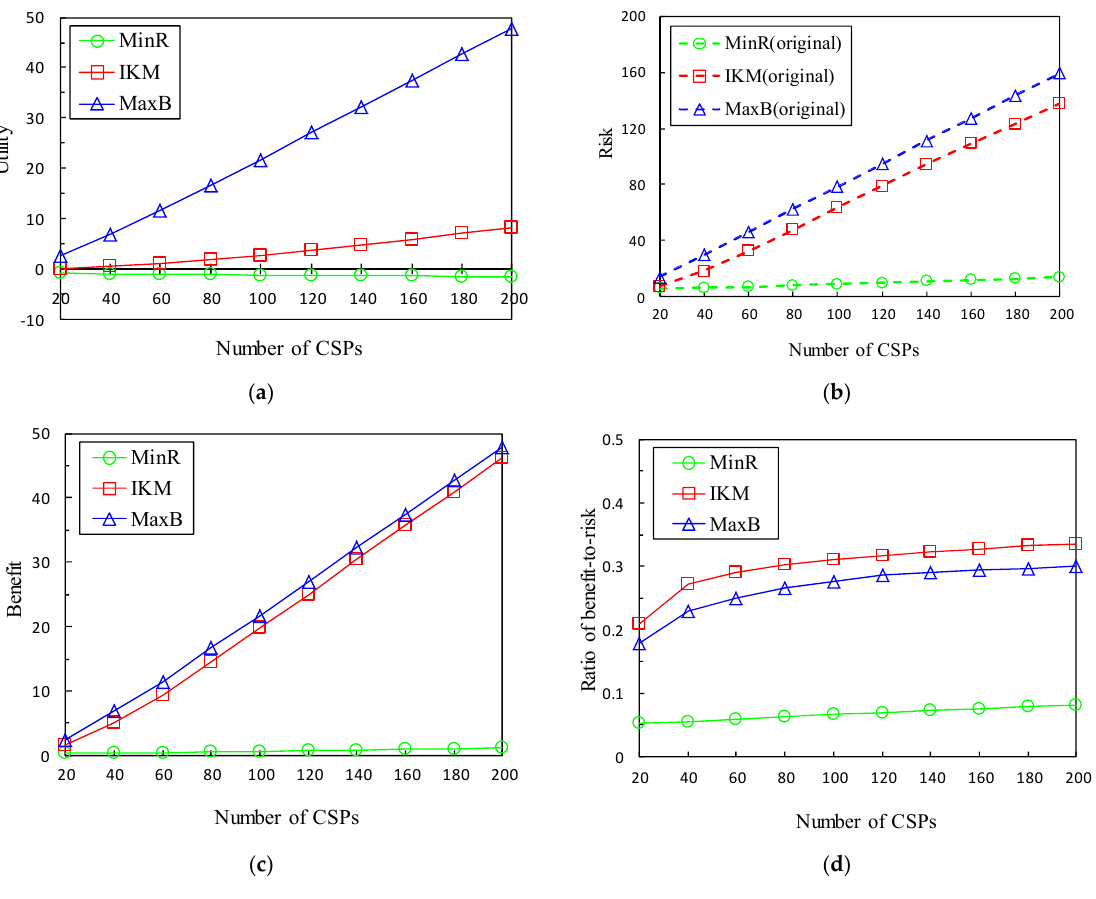
Figure 6. Effectiveness vs. number of CSPs (Set #1.1). ( a ) Utility; ( b ) risk; ( c ) benefit; ( d ) benefit − to − risk ratio.